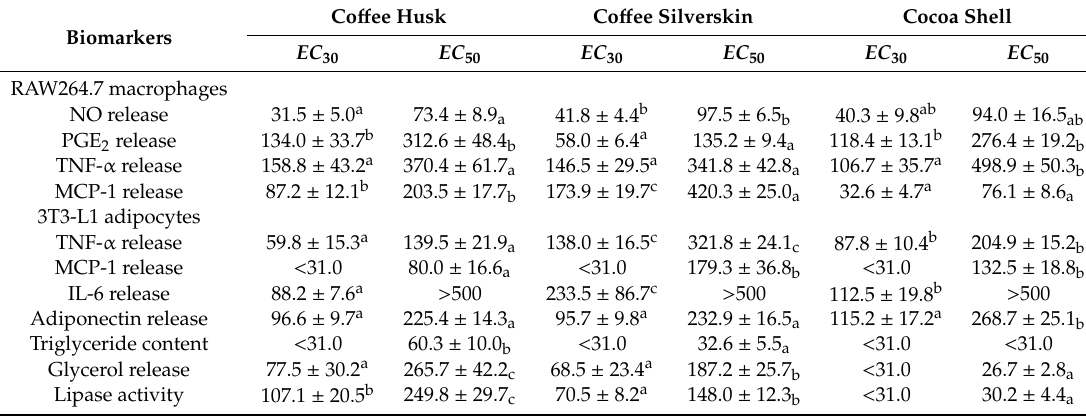
Anti-inflammatory e ff ect of co ff ee husk, co ff ee silverskin, and cocoa shell extracts (31–500 µ g / mL) regulating NO, PGE 2 , TNF- α , and MCP-1 release in lipopolysaccharide (LPS)-stimulated RAW264.7 macrophages, and TNF- α , MCP-1, IL-6, adiponectin, intracellular triglyceride content, extracellular glycerol release, and lipase activity conditioned media (CM)-stimulated in 3T3-L1 adipocytes. Values are expressed as mean ( µ g / mL) ± SD ( n = 3). Di ff erent letters among rows indicate significant di ff erences ( p < 0.05) according to ANOVA and Tukey’s multiple range